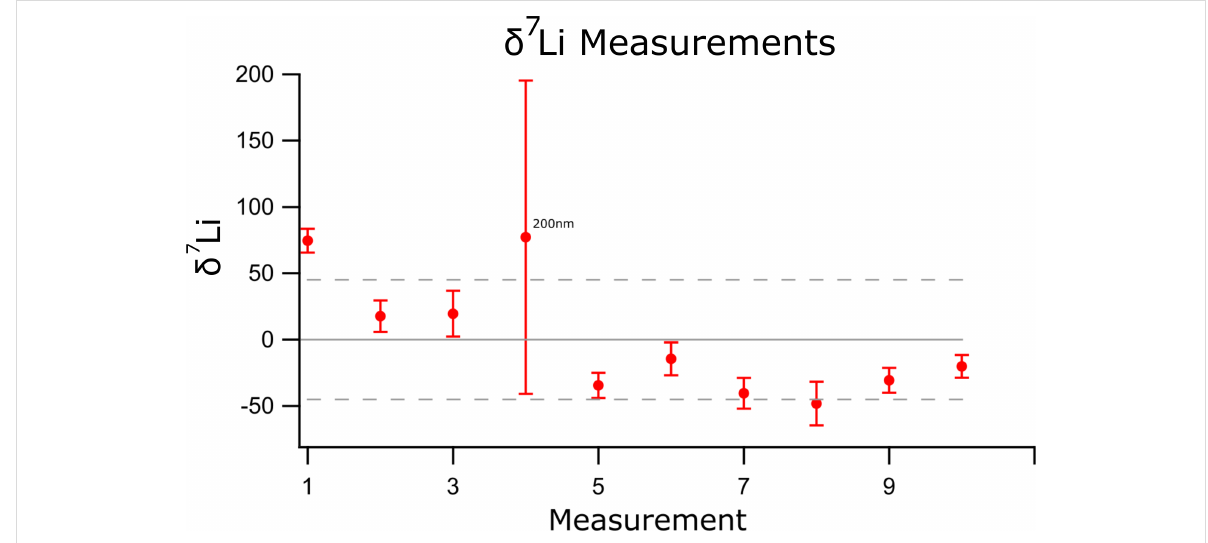
Figure 9: The relative δ 7 Li ratios for regions within the same grain of Spodumene. Values are not calibrated to an external standard, but instead to the average ratio across all measurements, which should lead to values of zero for isotopically homogeneous material. The internal statistical counting error is shown in red for each point with the external error across all measurements in grey.